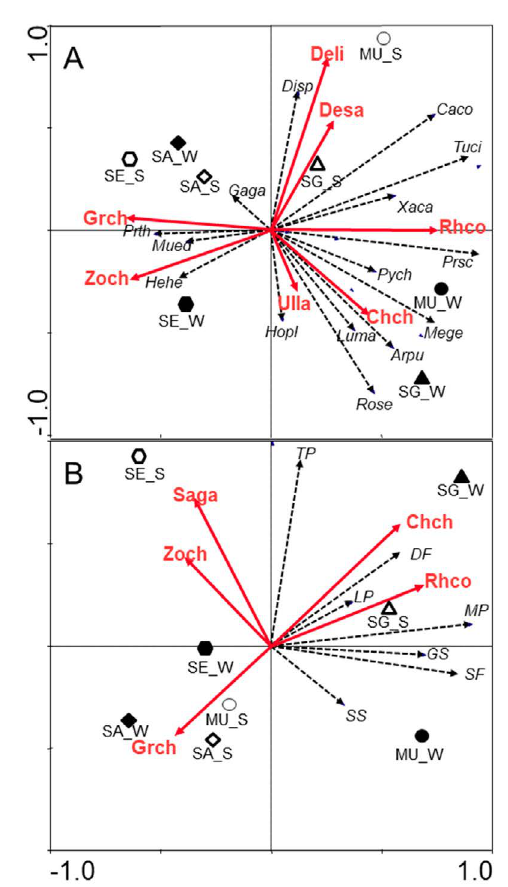
Fig. 3. – Redundancy analysis (RDA) of spatial and temporal variation of invertebrate epifauna (A) and trophic groups (B). Habitat-season distribution in the RDA biplot: SA_S=sand summer, SA_W=sand winter, MU_S=mud summer; MU_W=mud winter; SG_S=sand- gravel summer, S_GW=sand-gravel winter; SE_S=seagrass summer, and SE_W=seagrass winter. Significant macroalga species (red solid arrows): Chondracanthus chamissoi (Chch), Ulva lactuca (Ulla), Delesseria sanguínea (Desa), Rhodymenia corallina (Rhco), Desmarestia lingulata (Deli), Gracilaria chilensis (Grch), Sarcodiotheca gaudichaudii (Saga) and Zostera chilensis (Zoch). The code of invertebrates (A); Gaga ( Gaudichaudia gaudichaudi ), Disp ( Diloma sp ), Caco ( Cancer coronatus ), Tuci ( Turritella cingulata ), Xaca ( Xanthochorus sp ), Prsc ( Priene scabrum ), Pych ( Pyura chilensis ), Mege ( Meyenaster gelatinosus ), Luma ( Luidia magallánica ), Arpu ( Argopecten purpuratus ), Rose ( Romaleon setosus ), Hopla ( Homalaspis plana ), Hehe ( Heliaster helianthus ), Mued ( Mulinia edulis ) and Prth ( Prothothaca thaca ). The trophic groups (B) are listed in Table